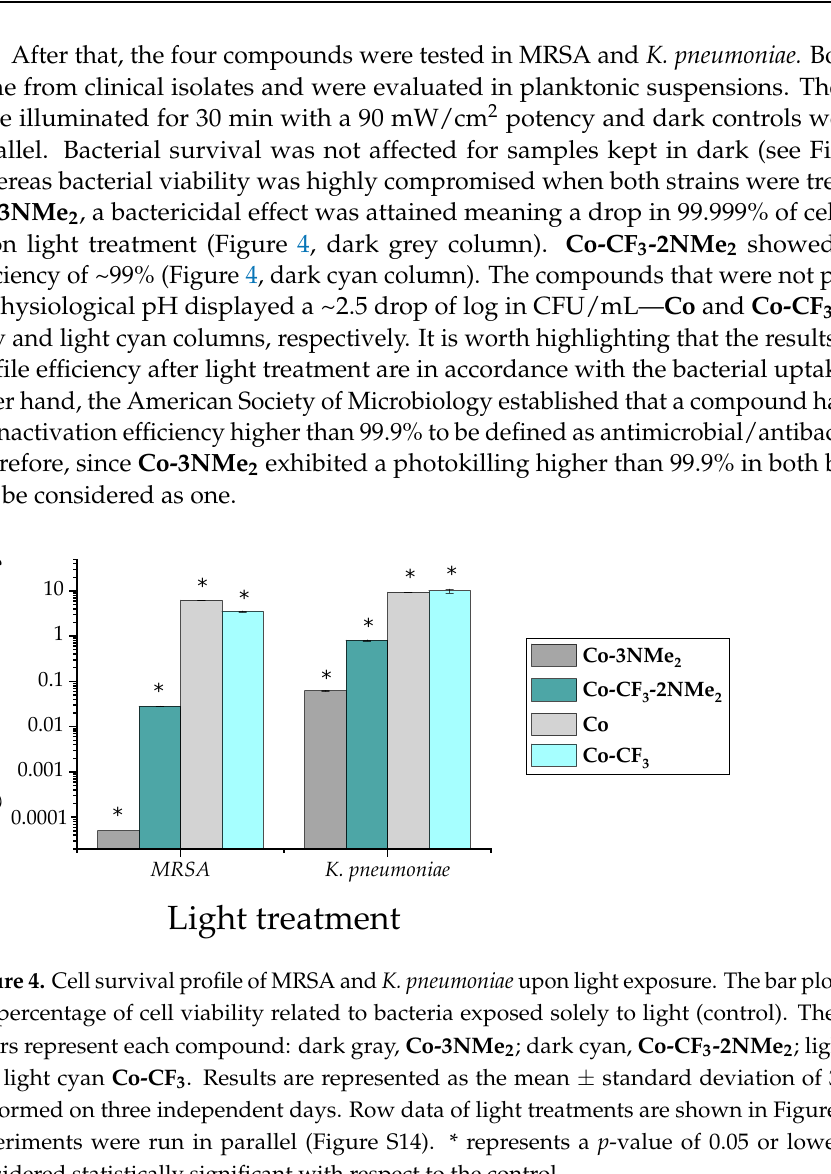
Table 2. Zeta potential ( ζ ) measurements in bacterial systems incubated with PSs in buffer PBS. Strain Co-CF 3 -2NMe 2 Co-3NMe 2 Co Co-CF 3 MRSA